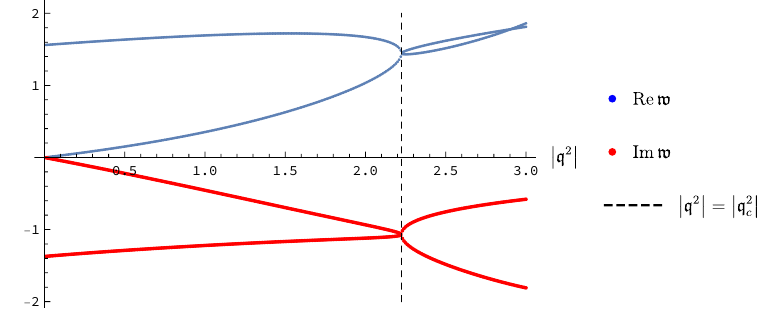
Figure 9 . Quasinormal spectrum level-crossing: the real (blue curves) and the imaginary (red curves) parts of the hydrodynamic shear mode and the closest gapped quasinormal mode dispersion relations plotted as functions of j q 2 j at the (cid:12)xed phase (cid:18) (cid:25) 0 : 338858 (cid:25) of the complex momentum q 2 = j q 2 j e i(cid:18) . At j q 2 j = j q 2 j (cid:25) 2 : 224, the level-crossing occurs. c